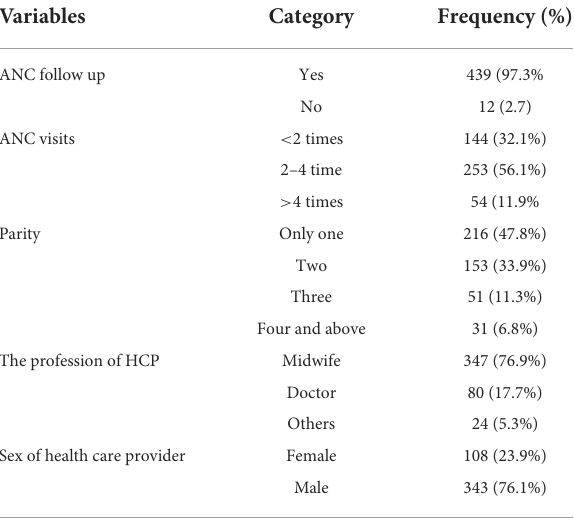
TABLE 2 Provider related and obstetric characteristics of the respondents among mothers who gave birth at Hadiya Zone public hospitals Southern Ethiopia, 2020 ( n =